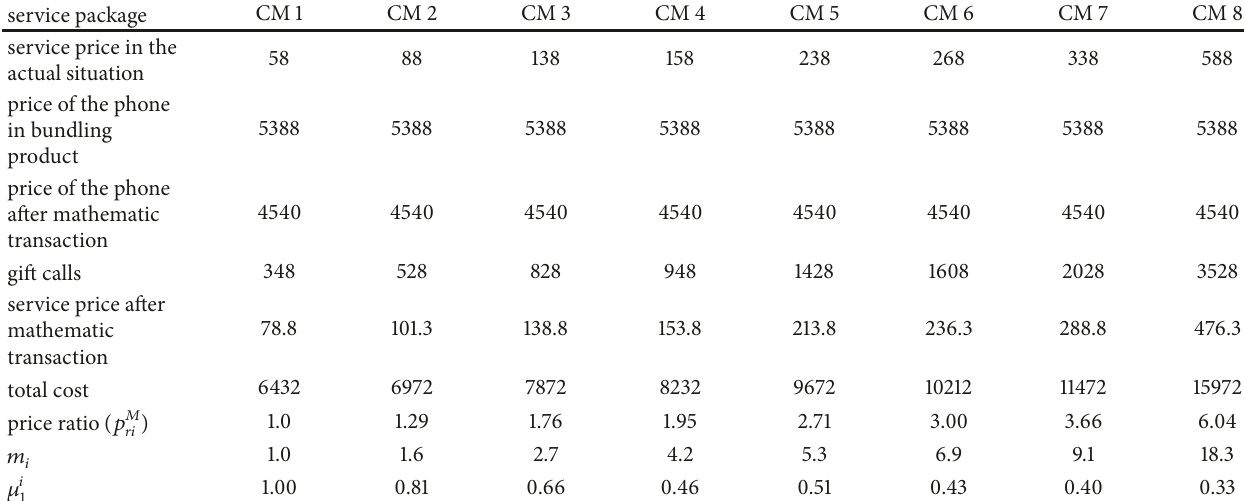
Table 3: Details of the service package offered by